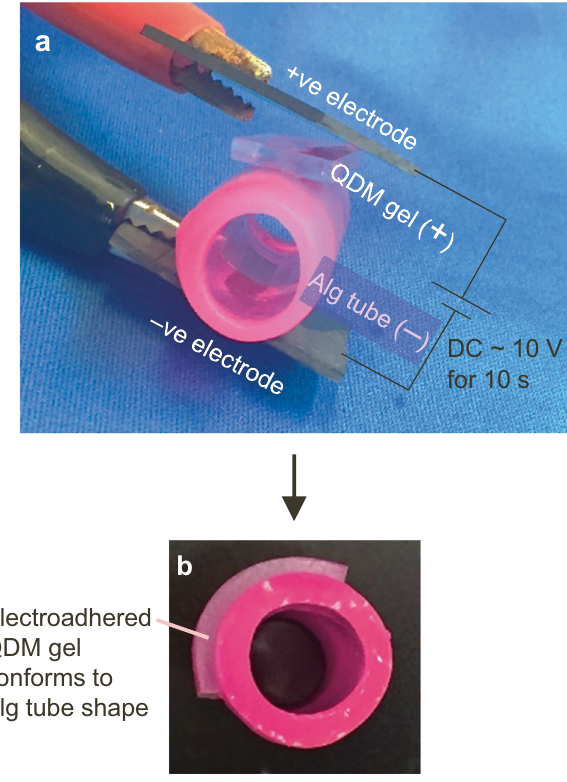
Fig. 2 Electroadhesion of QDM gel-strip to Alg tube. a The gel and tube are contacted with graphite electrodes, with the positive electrode touching the cationic QDM gel and the negative electrode touching the anionic Alg tube. b Upon applying 10 V of DC for 10 s, the gel gets tightly adhered to the tube and conforms to the tube shape. In cases where a puncture is made in the tube wall, adhesion of the gel over the puncture location serves to patch up the puncture (see next fi gure).